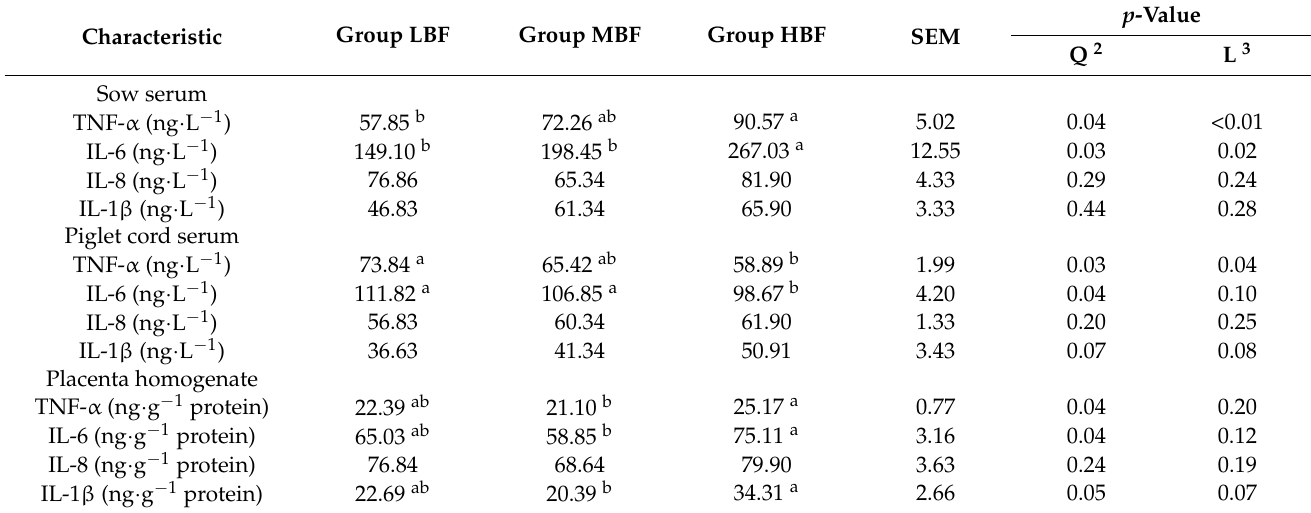
Table 4. The concentration of pro-inflammatory cytokines in sow serum, piglet cord serum, and placenta homogenate 1